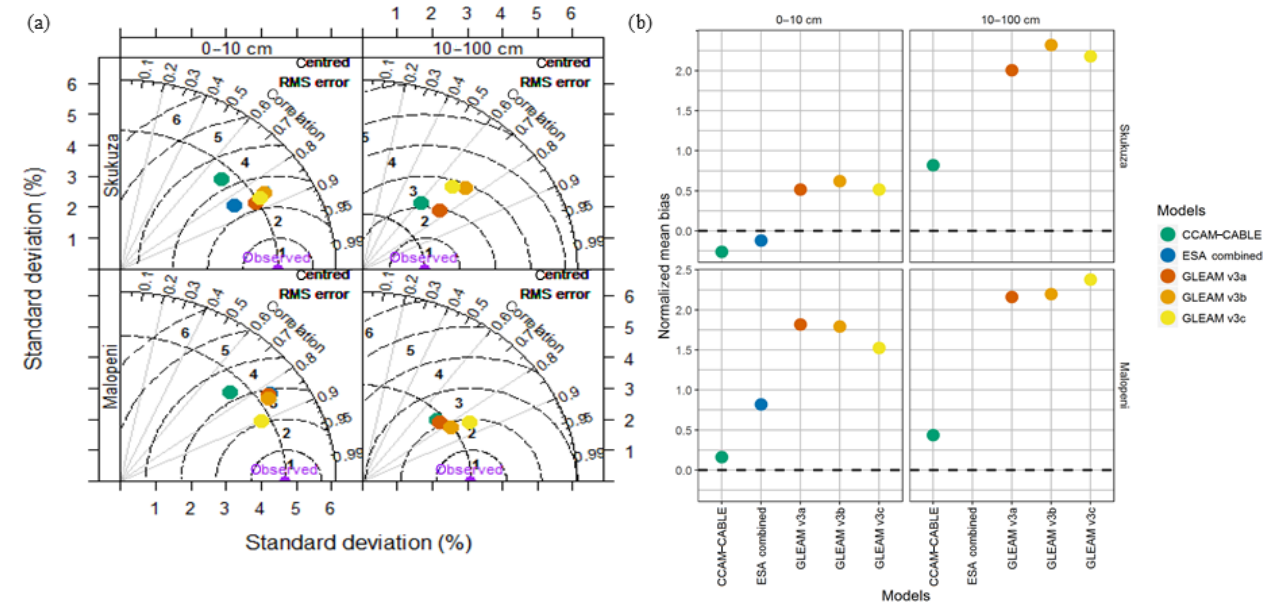
Figure 4. (a) Taylor plots quantitatively comparing monthly modelled soil moisture to observations at Skukuza (2001–2014) and Malopeni (2008–2013), at both the surface (0–10cm) and root zone (10–100cm). The vertical solid grey lines represent the correlation coefficient. The broken black line cutting through the semi-circle broken black lines represents the standard deviation of the in situ observation. The semi- circle broken black lines represent the centred root mean squared error. (b) Normalized mean bias (NMB) of surface (0–10cm) and root-zone (10–100cm) soil moisture, computed between the various soil moisture products and the in situ observations at Skukuza and